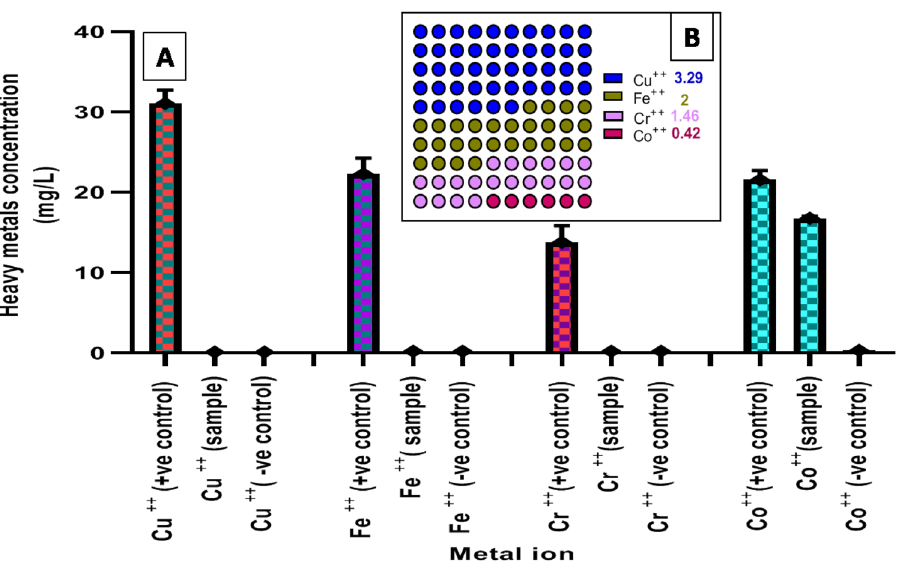
Figure 11. The affinity of SEDCFs toward Cu ++ , Fe ++ , Cr ++ and Co ++ in metal solutions ( A ) and its sorption capacity q (mg/g) ( B